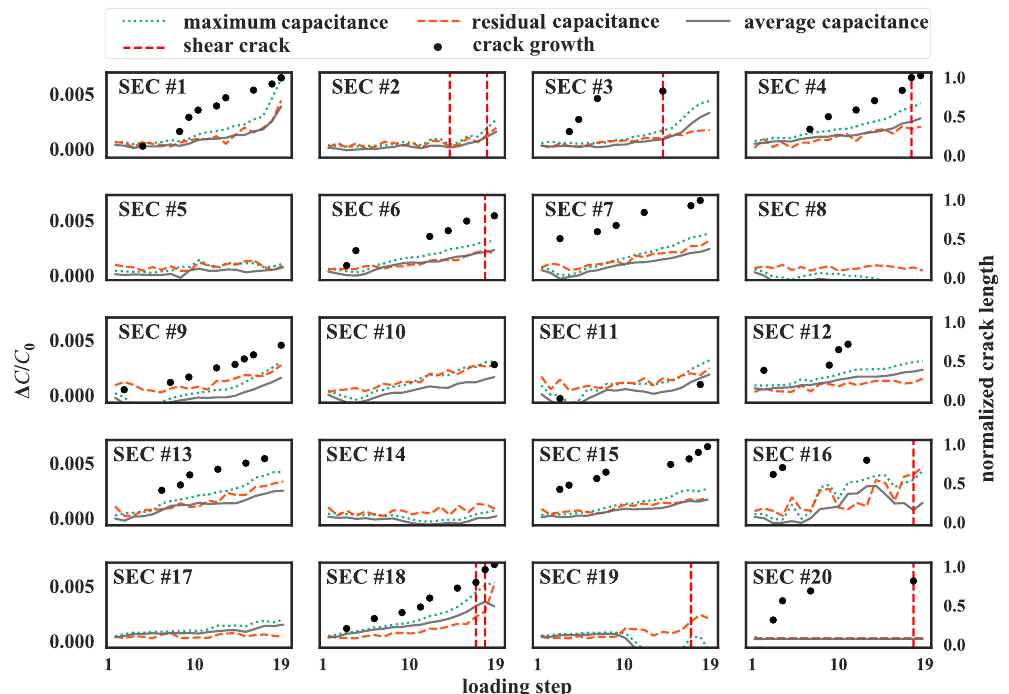
Figure 11. Comparison of maximum, residual, and average relative change in capacitance measured by the SECs and normalized crack growth length under each loading step (loading step 1 to